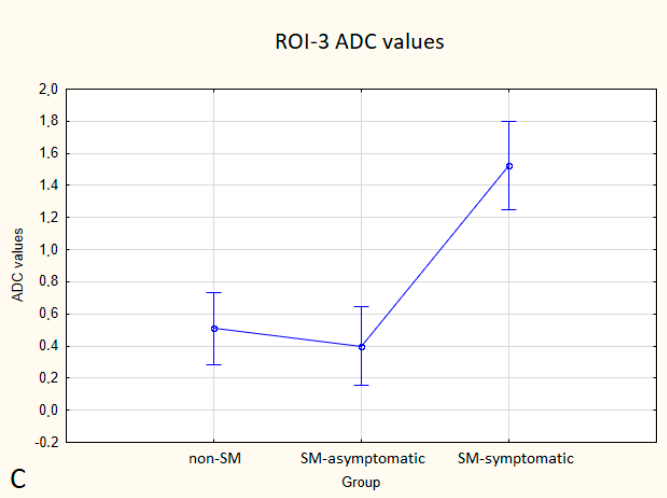
Figure 6. Boxplots comparing ADC values in ROI-1 ( A ), ROI-2 ( B ), ROI-3 ( C ) between the non-SM, SM-symptomatic and SM-asymptomatic groups.